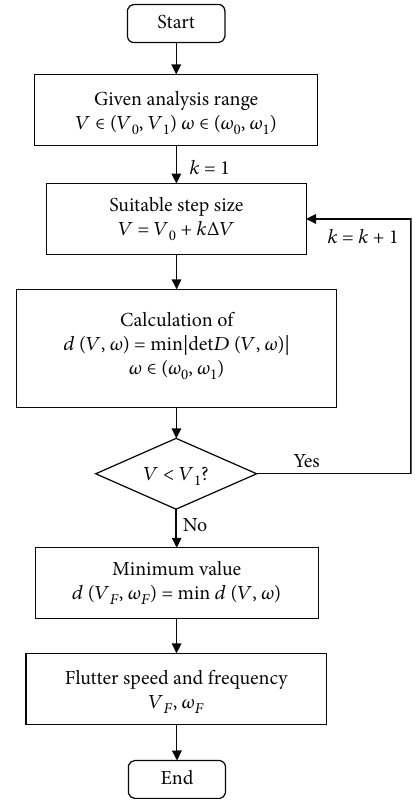
Figure 5: Flow chart of fl utter boundary